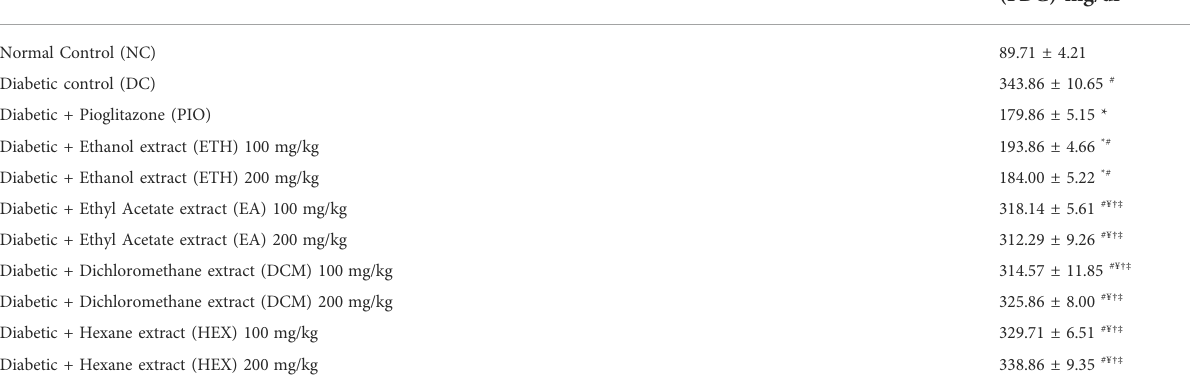
TABLE 1 Effect of Matricaria aurea (MA) extracts on Fasting blood glucose level.